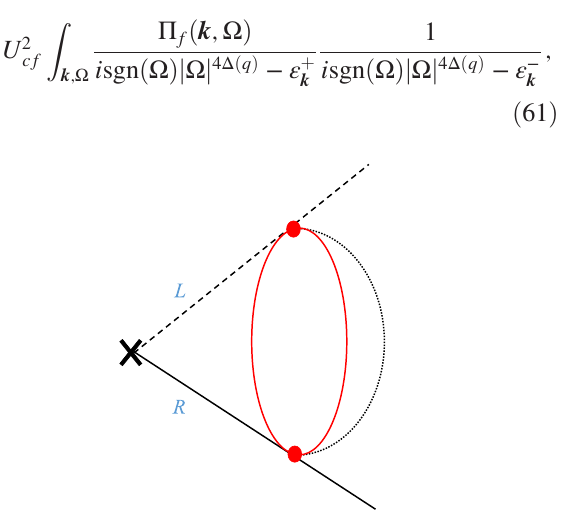
FIG. 7. One-loop vertex correction to the 2 k operator, δ H in F Eq. (52) (denoted by a cross). The solid and dashed lines correspond to the c -fermion Green ’ s functions for the two antipodal patches R and L . Red lines denote f Green ’ s functions, and red dots represent the V ijkl